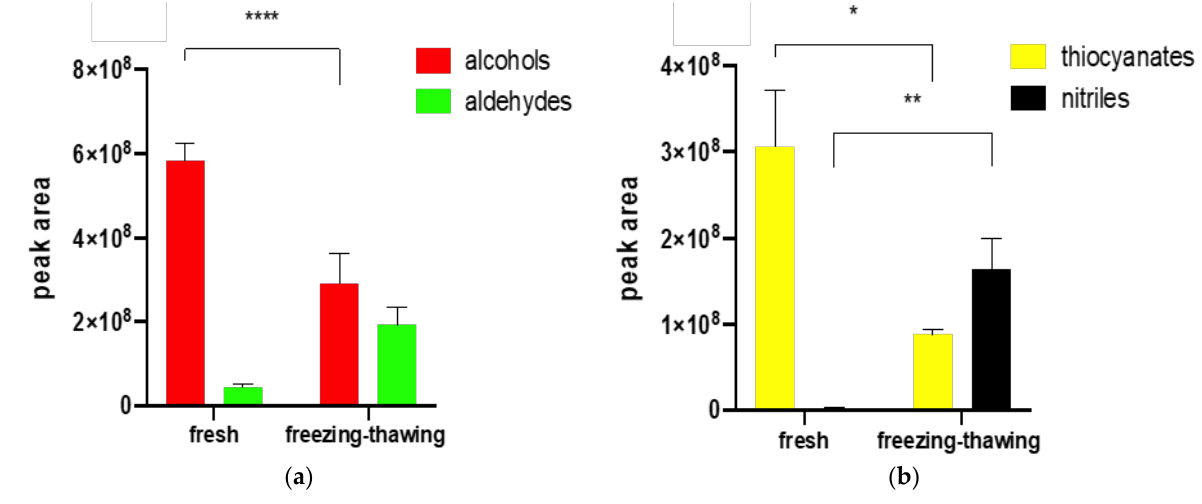
Figure 1. Influence of freezing-thawing of broccoli florets on the amount of extracted ( a ) LOX derived and ( b ) myrosinase derived volatiles by SPME, compared to those extracted from fresh florets. Each bar graph is expressed as mean value ± standard deviation. * p ≤ 0.05, ** p ≤ 0.01, **** p ≤ 0.0001 ( t